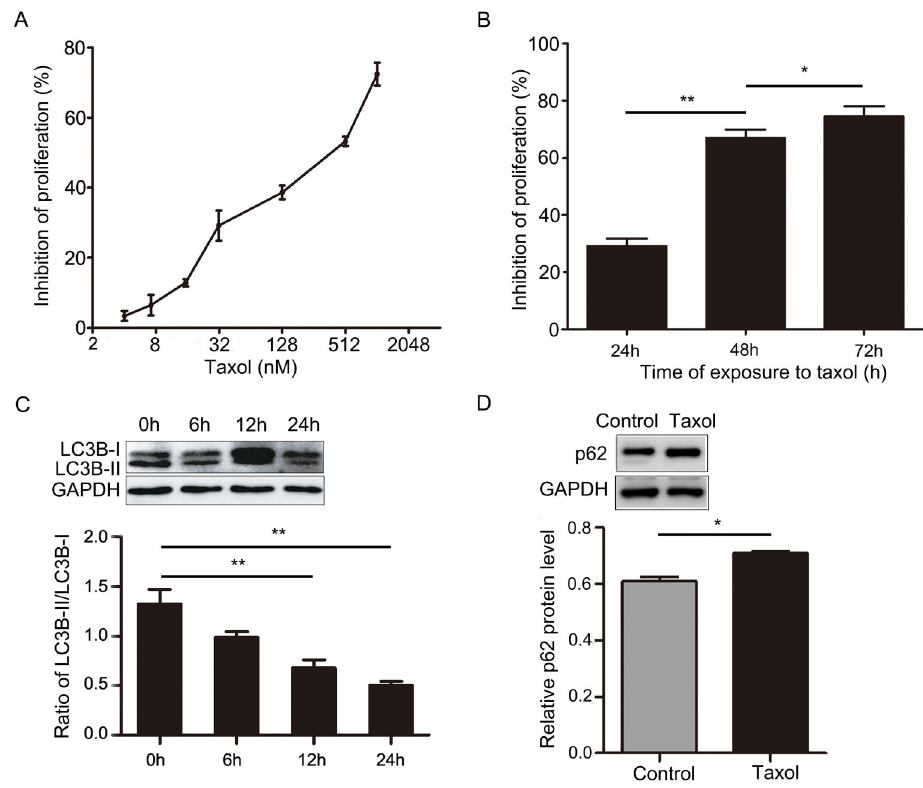
Figure 1. A , Cell proliferation was determined by the CCK-8 assay after treatment with different concentrations of Taxol for 24 h. B , Cell proliferation was determined by the CCK-8 assay after treatment with 31.2 nM Taxol at different time-points. C , Expression of LC3B-I and LC3B-II in MCF-7 cells was determined by western blotting after treatment with 31.2 nM Taxol at different time-points. D , p62 expression in MCF-7 cells was determined by western blotting after treatment with 31.2 nM Taxol for 24 h. Data are reported as means ± SD of three independent experiments. *P o 0.05, **P o 0.01, vs control group